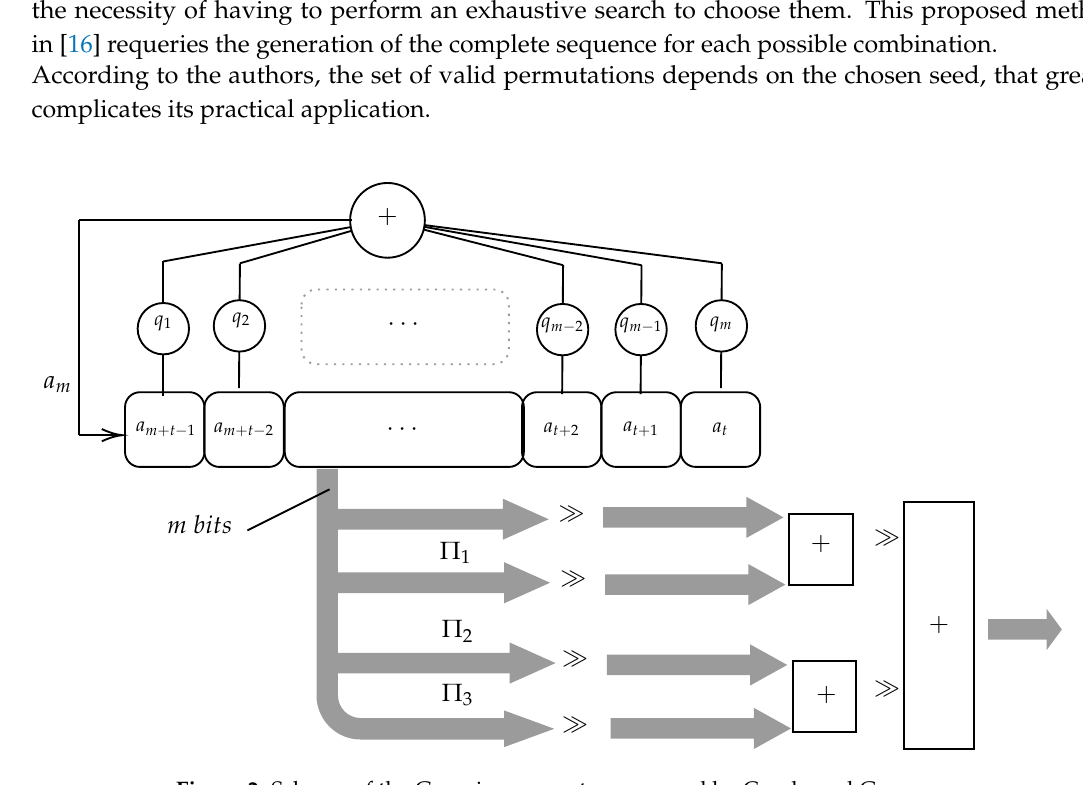
Figure 2. Scheme of the Gaussian generator proposed by Condo and